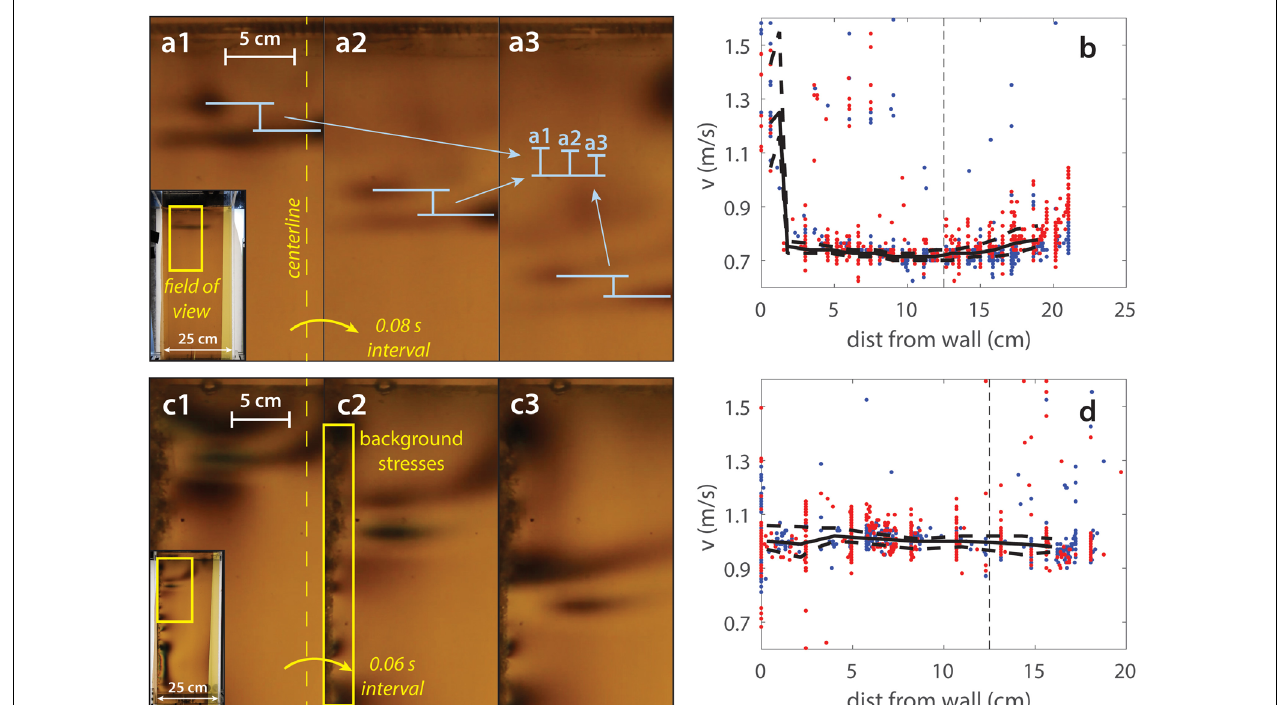
FIGURE 9 | (a) A close-up view of a wave propagating downward (field of view indicated in inset), from Ex10. The wave travels slightly faster near the wall than in the center (yellow dashed line). The relative distance between offset wave crests decreases with time, indicating a higher velocity near the wall. (b) Velocity measurements at different distances from the wall. The wave appears faint near the wall, so measurements there are more scattered. The moving median values (horizontal solid line) and associated median absolute displacements (horizontal dashed lines) are shown, as well as the centerline (vertical dashed line). (c,d) Similar measurements from Ex11. We first separated the gelatin from the wall, causing small stress heterogeneities along the wall. The resulting velocity measurements show no obvious wall effect.